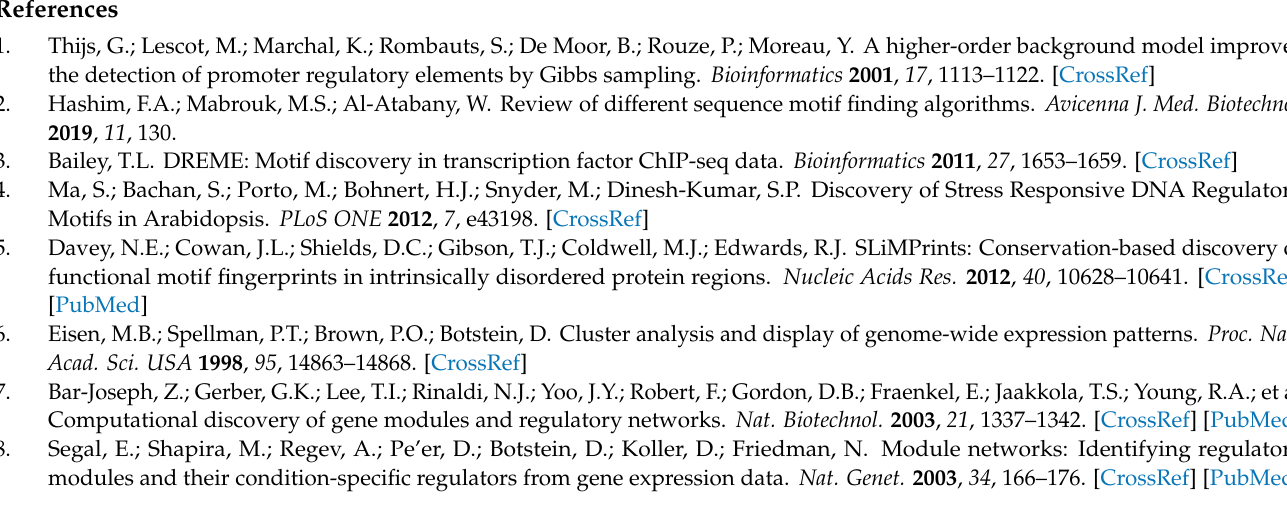
sites vs. gene length; Figure S2: Number of enriched GO terms using different coefficient cutoff values; Table S1: coefficient matrix for constructing GRN; Table S2: Predicted functional annotations for each TF from global GRN; Table S3: Predicted functional annotations for each TF from abiotic stress specific GRN; Table S4: Predicted functional annotations for each TF from biotic stress specific GRN; Table S5: Predicted functional annotations for each TF from development specific GRN; Table S6: Predicted functional annotations for each TF from hormone response specific GRN; Table S7: Predicted 6-mer binding motifs for each TF; Table S8: Predicted 7-mer binding motifs for each TF; Table S9: Predicted 8-mer binding motifs for each